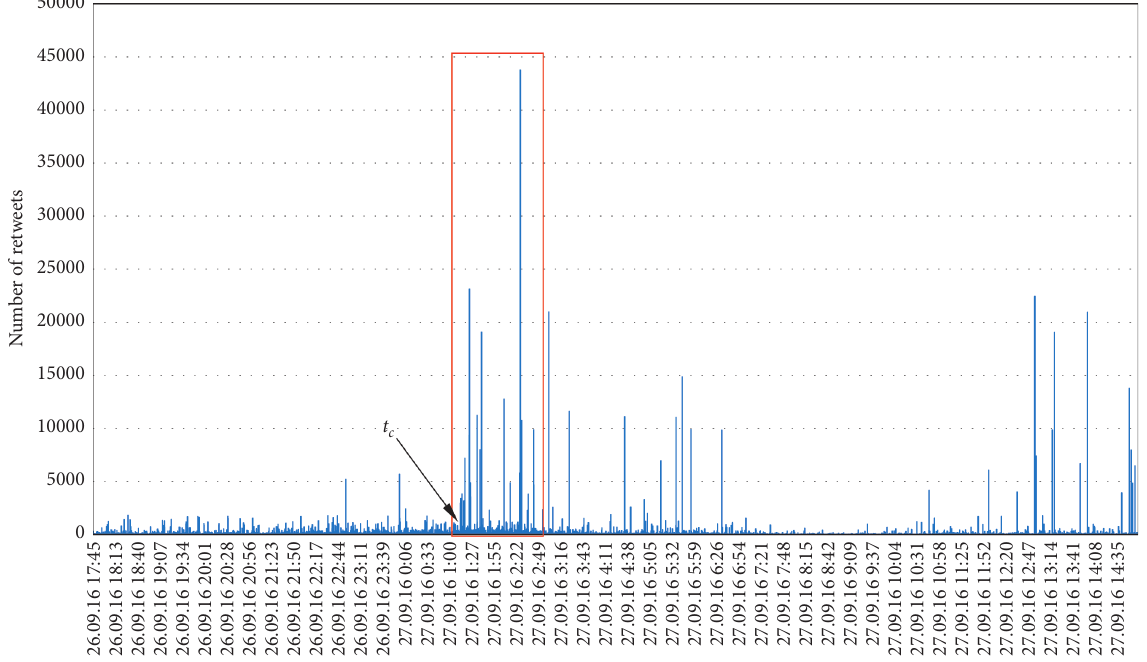
Figure 1: The dynamics of retweets corresponding to the first debate. t state.